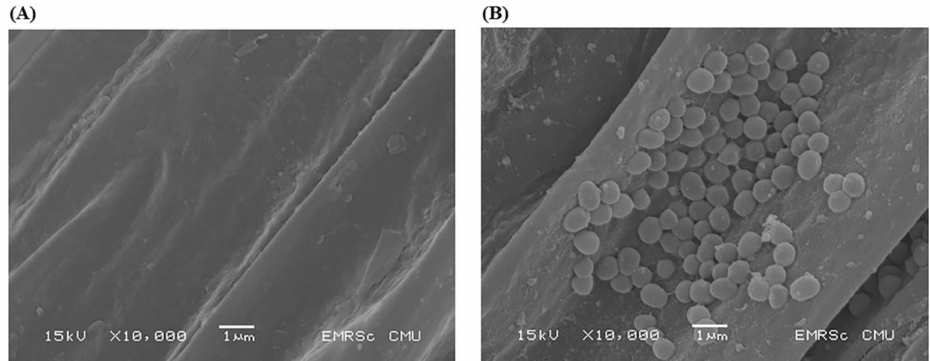
Figure 3. Scanning electron micrographs of tomato roots obtained from 25-day-old tomato seedlings. ( A ) non-inoculated tomato seedlings, ( B ) D. abyssi MT1.1 T -inoculated tomato seedlings.